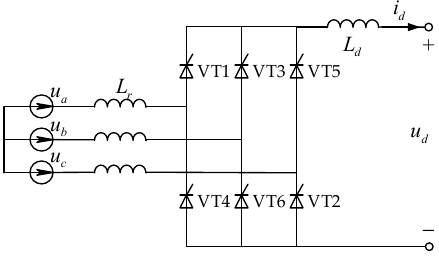
Figure 2. Six pulse rectifier system working principle diagram.